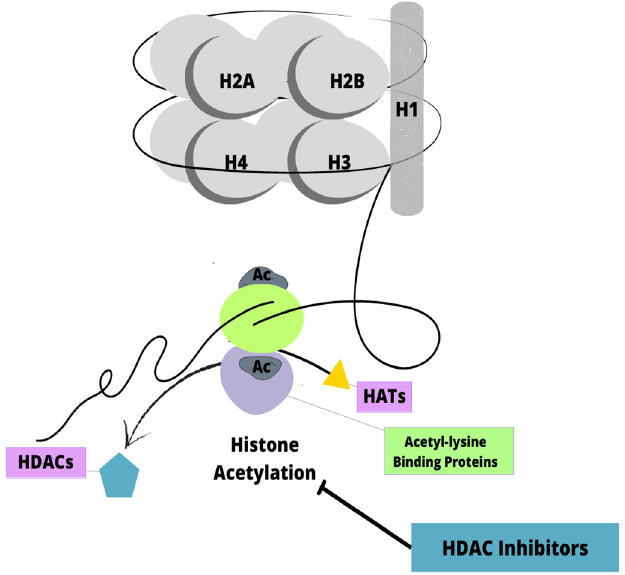
Figure 4. Mechanism of action of HDAC inhibitors. HATs-histone acetylases, HDACs-histone deacetylases.